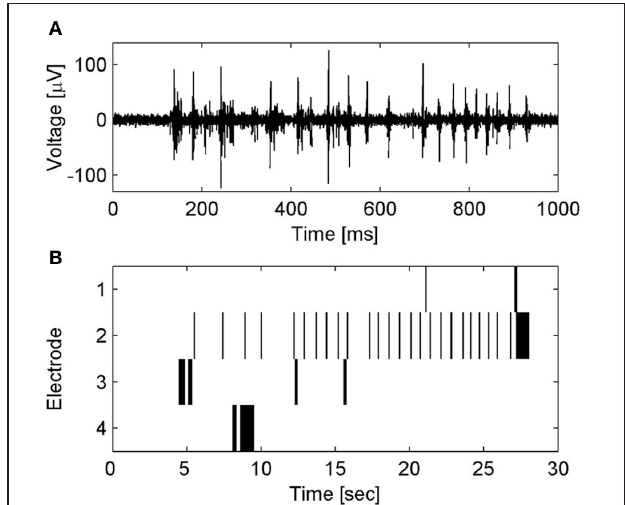
FIGURE 5 | Spontaneous electrical activity of neuronal clusters on CNT MEA. (A) Voltage traces of spontaneous electrical activity recorded from a CNT electrode. (B) Raster plot of the spontaneous spiking activity in several CNT electrodes. Activity patterns are characterized by bursting events; short time windows (several hundreds of milliseconds) of rapid collective neuronal firing, which are followed by long intervals (seconds) of sporadic firing. For further details see Shein et al.